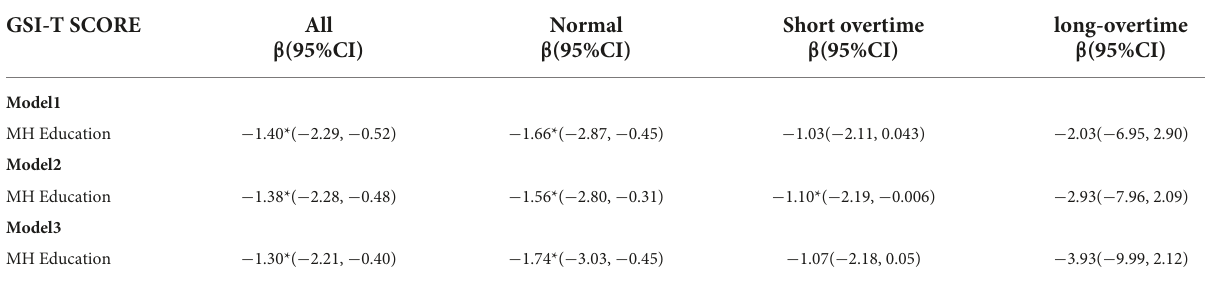
TABLE 4 The association between SCL-90 GSI-T score and mental health education by different overtime